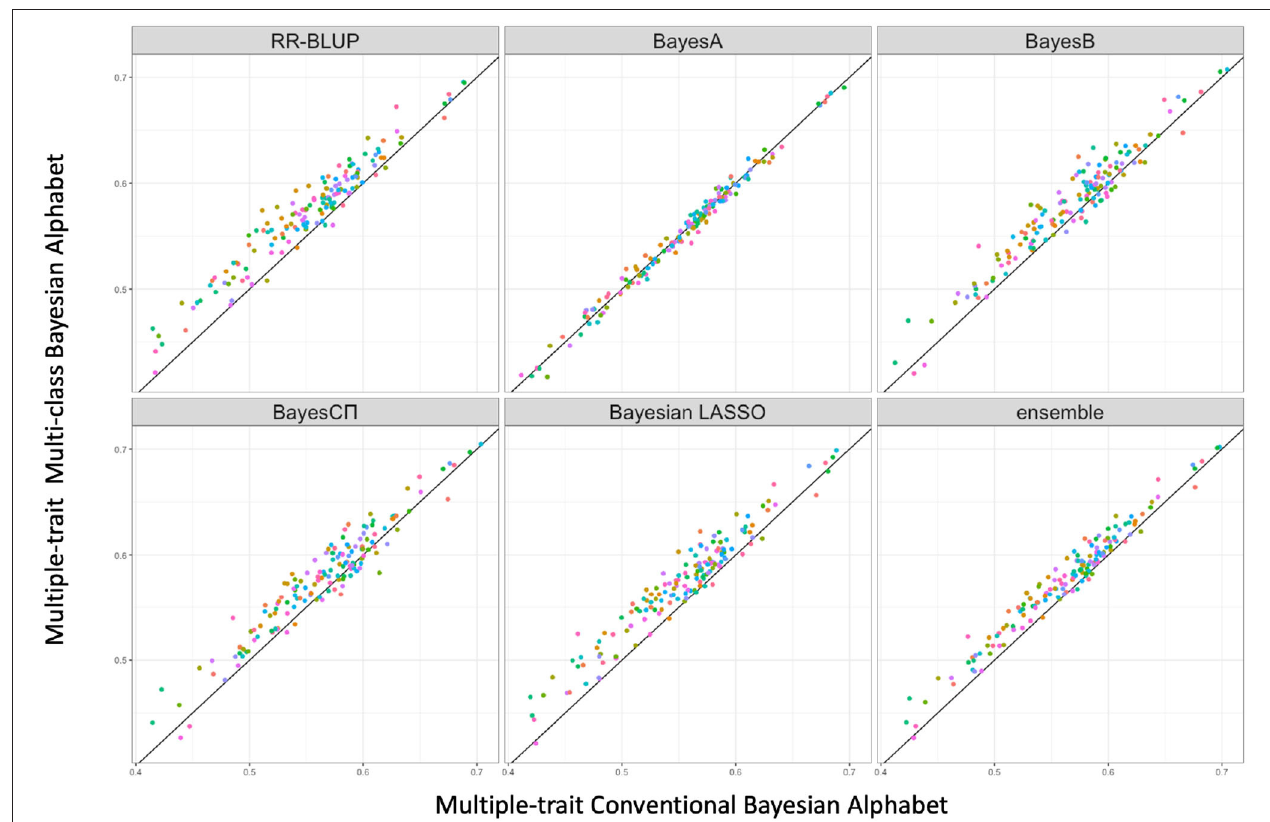
FIGURE 2 | The pairwise predication accuracy comparison between conventional Bayesian Alphabet and multi-class Bayesian Alphabet on multiple-trait simulated data. The 30 simulated datasets were distinguished by color; the x-axis represents the genomic prediction accuracy obtained from conventional Bayesian Alphabet method; the y-axis represents the genomic prediction accuracy obtained from multi-class Bayesian Alphabet method; the diagonal line is used for reference such that a dot above the line represents a validation with higher accuracy for multi-class Bayesian Alphabet. Significant differences were found between multi-class Bayesian Alphabet and conventional Bayesian Alphabet with RR-BLUP, BayesB, BayesC π Bayesian LASSO, and ensemble approach, respectively ( p < 0.1).